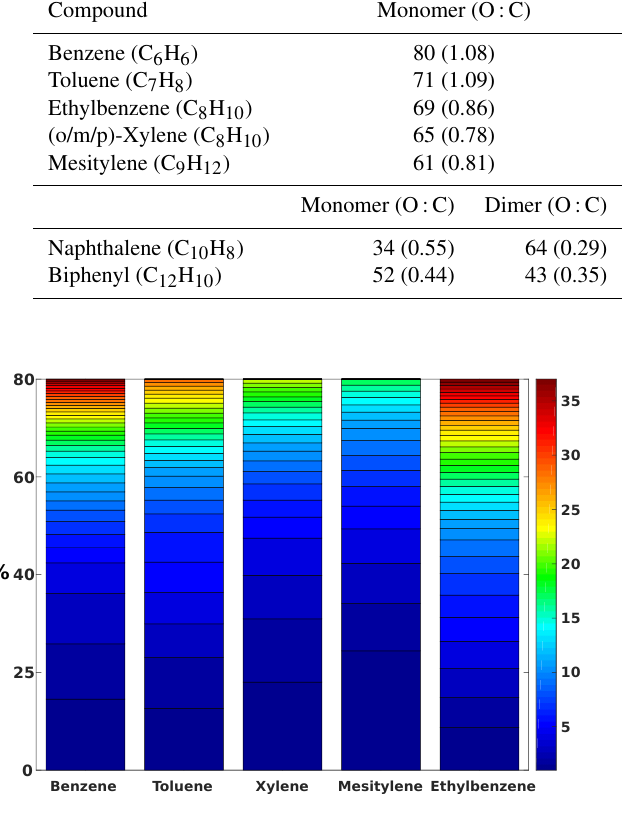
Figure 4. Graphical representation of the cumulative peak lists for the five monocyclic ArHCs. The bar plot shows the cumulative con- tribution of the most abundant HOM species to 80% of the total de- tected signal for each single-ring ArHC. Each color of the stacked bar plots denotes a certain number of cumulative compounds. In the series benzene, toluene, xylene, and mesitylene, a gradually smaller number of different HOM species is needed to explain 80% of the total signal. However, this trend with the increase in the number of substituents is not met by ethylbenzene. This may be linked to the fact that dimers with an unexpectedly low number of hydro- gen were observed. Ethylbenzene shows a lower fraction of HOM NO − adducts as 3